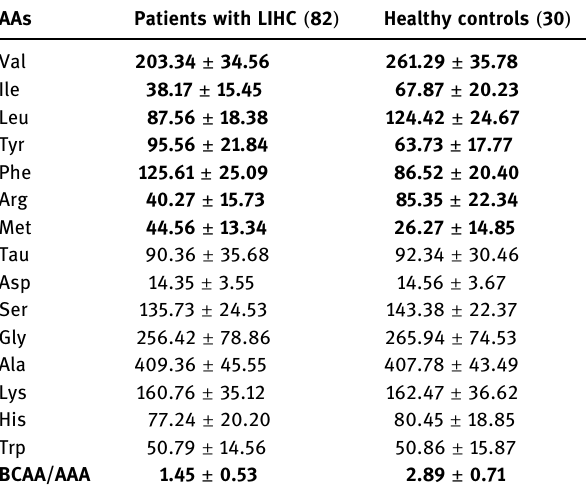
Table 1: Serum AA pro fi les in patients with LIHC and healthy indi - viduals (